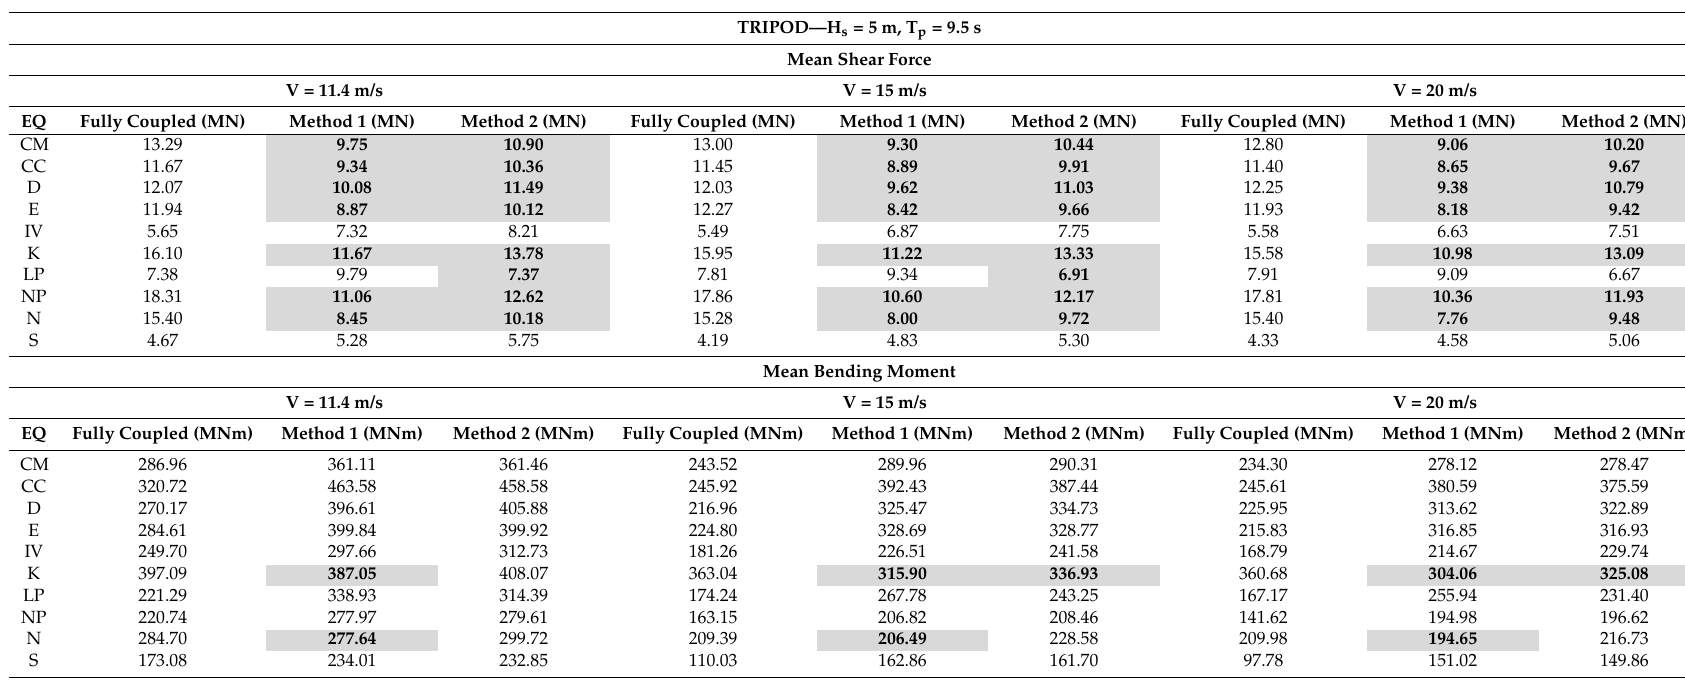
Table 6. Tripod: Mean shear-force and bending-moment demands at tower base, obtained by Methods 1-2 for sea state parameters H s = 5 m, T p = 9.5 s, all wind velocities and earthquake records listed in Table